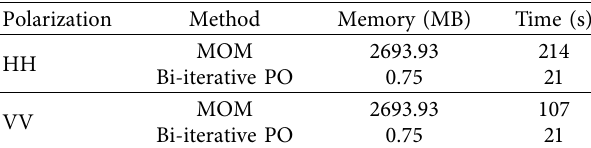
Table 1: CPU time and required memory in Figure